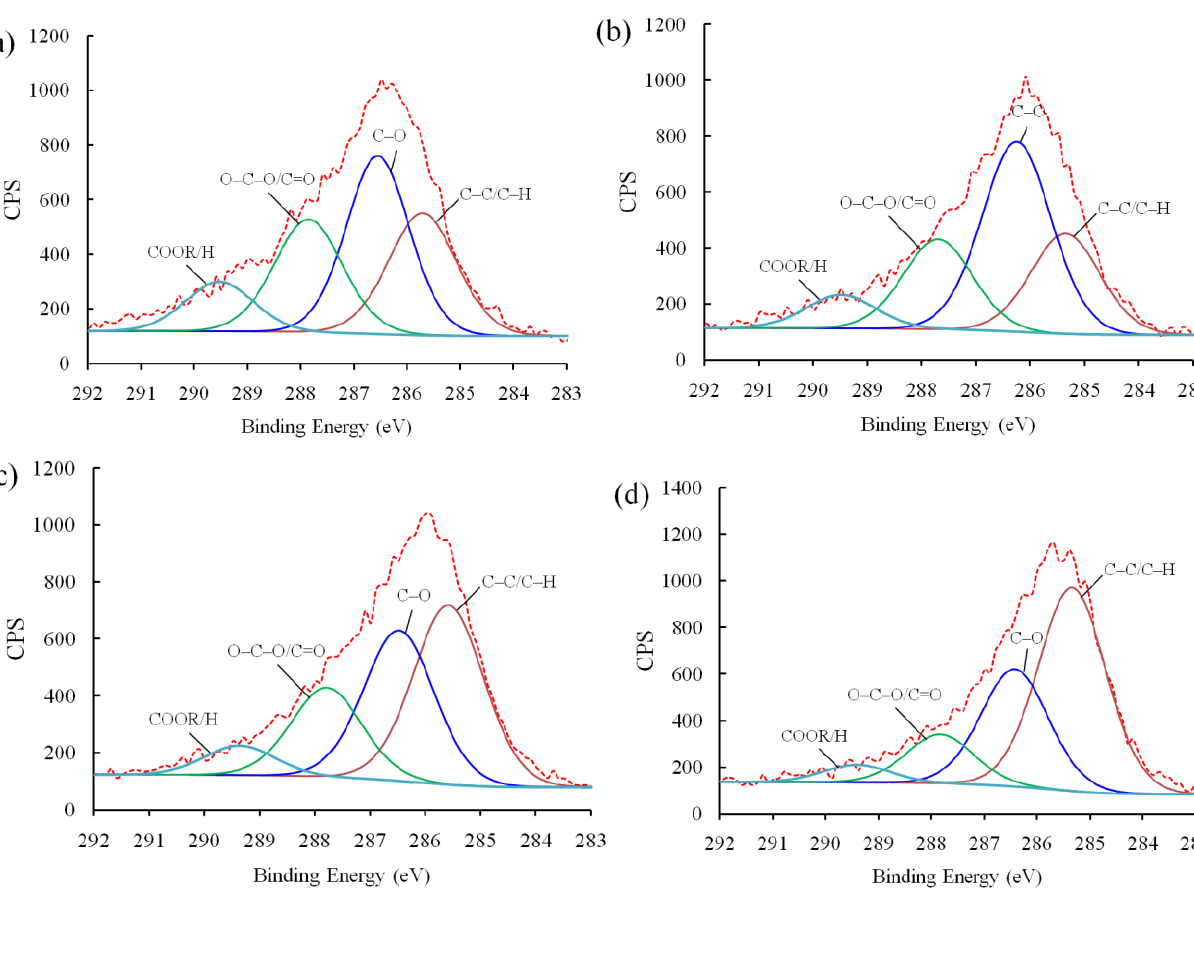
Figure 5. XPS spectra of C 1s peaks of plasma polymerized PEO-like film at ( a ) 5 W; ( b ) 10 W; ( c ) 15 W; and ( d ) 20W for 4